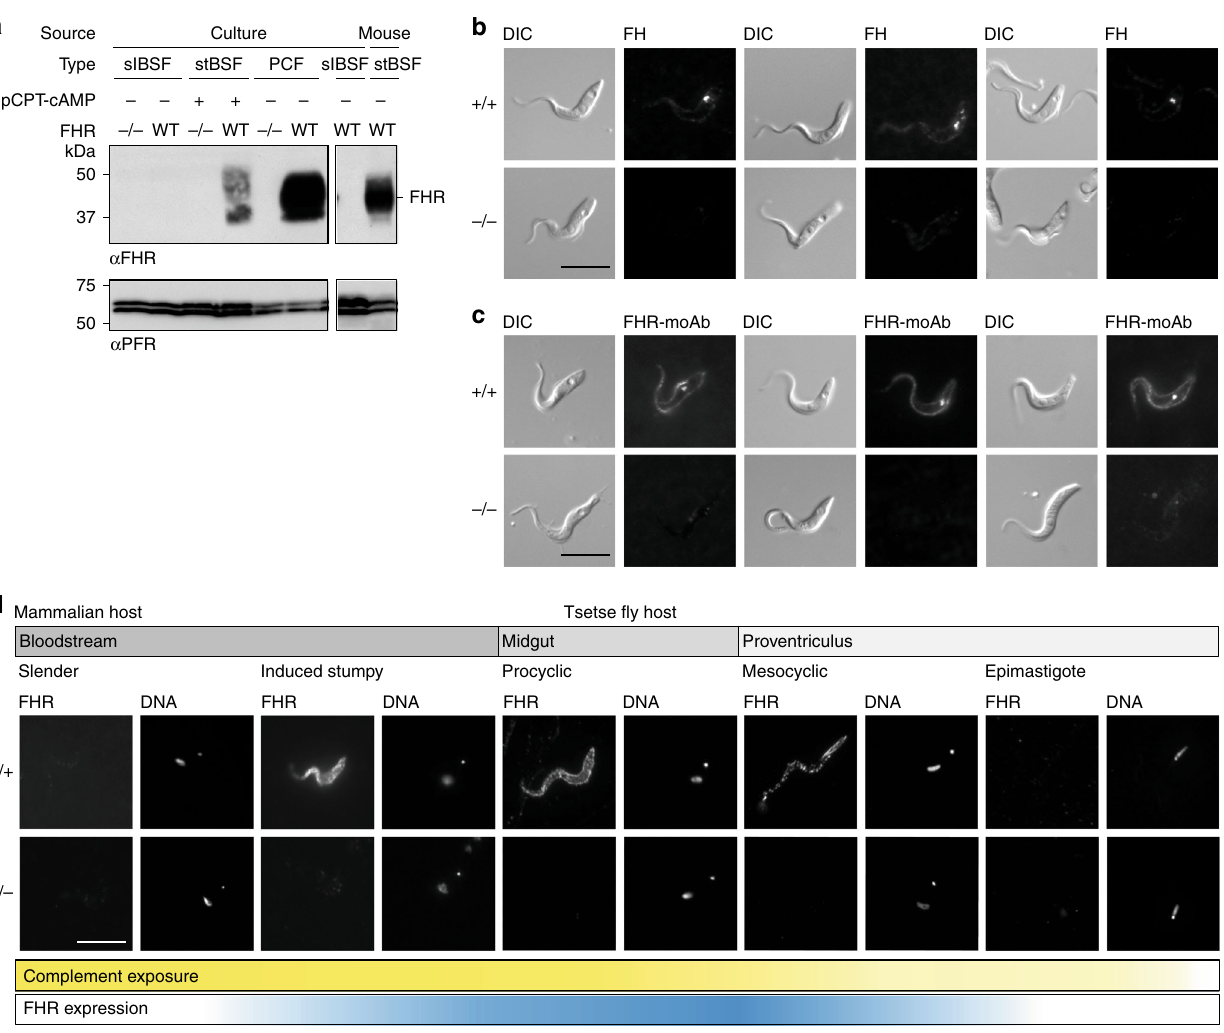
Fig. 5 FHR is upregulated on the cell surface of forms that are adapted to life in blood ingested by the tsetse fl y. a Western blot analysis probed with FHR antiserum ( α FHR) of whole-cell lysates from FHR + / + and FHR − / − slender BSFs, induced stumpy BSFs, and PCFs in culture and from FHR + / + stumpy BSFs from a mouse infection. Anti-PFR ( α PFR) was used as a loading control. b , c Live-cell-binding assay of 100 nM fl uorescent b bovine FH or c FHR-moAb to PCFs in culture. After 2 h, cells were fi xed in culture and visualized. Scale bar, 10 μ m. d Immuno fl uorescence analysis of localization of FHR during the majority of the T. brucei life cycle. Cells were collected, fi xed and then probed with FHR antiserum. Scale bar, 10 μ m. DNA, Hoechst staining of the nuclear and kinetoplastid DNA. Cells positioned with the posterior towards the top right corner. Bars beneath the microscope images represent where complement is present during the life cycle (yellow gradient) and FHR expression (blue gradient). Source data are provided as a Source Data fi